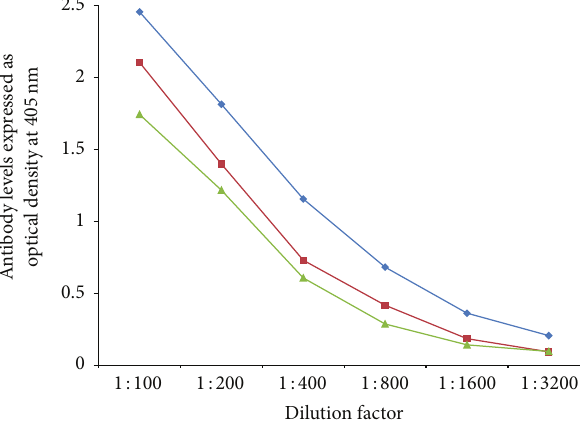
Figure 5: Serial dilution of IgG (blue diamond), IgA (green tri- angle), and IgM (red square) antibody against AQP4.